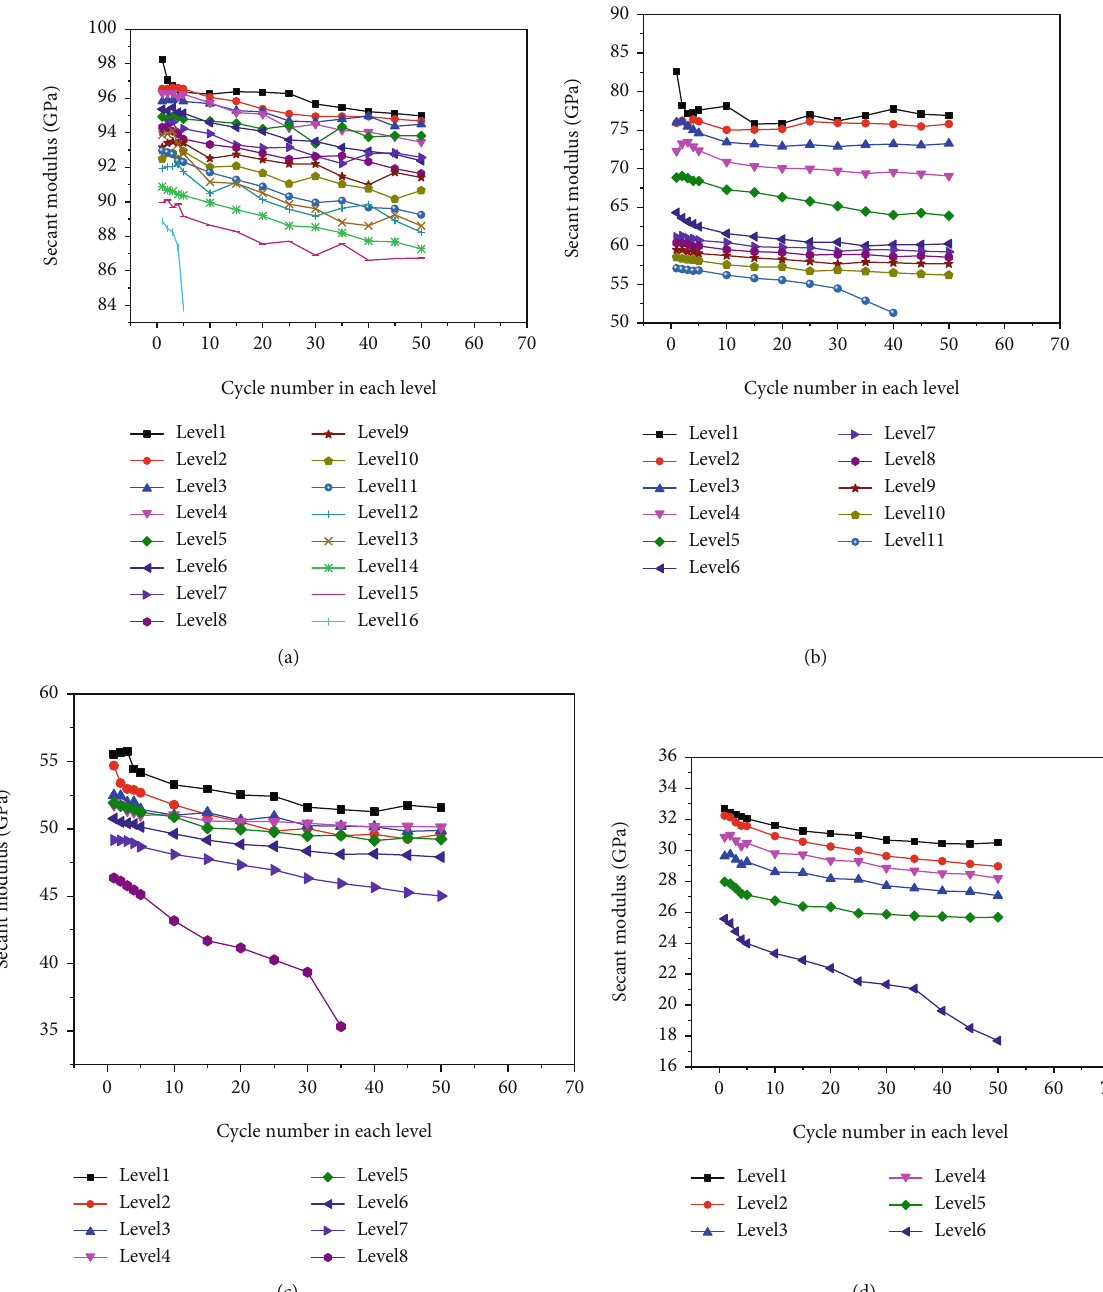
Figure 3: Evolution of secant modulus with cyclic number at various cyclic levels ((a – d) the initial natural fracture volume ratio is 0.68%, 1.03%, 1.53%, and 2.27%,